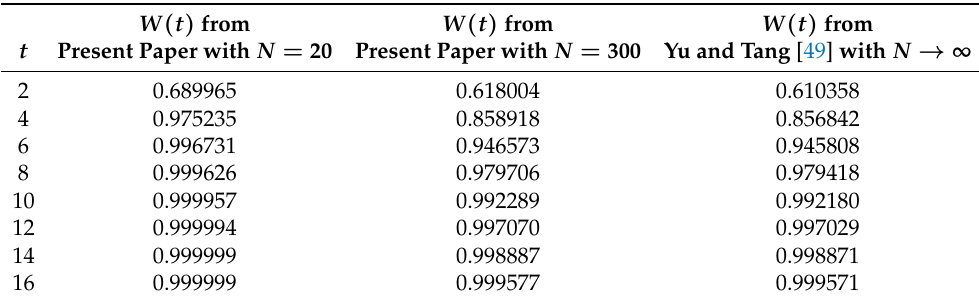
Table 4. Comparison among the CDF of sojourn times from Example 4 with the parameters λ = 6, µ = 1.6, a = 5, b = 5, N = 20/300 and ρ = 0.75.